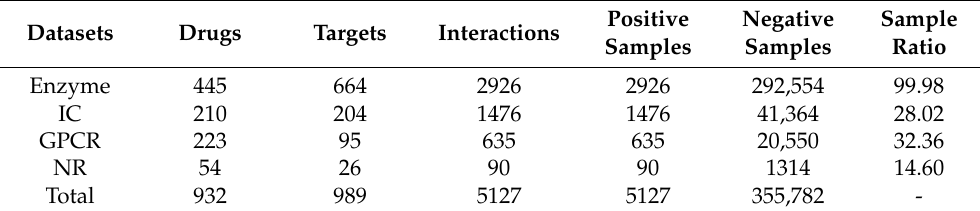
Table 4. The benchmark data sets used in this